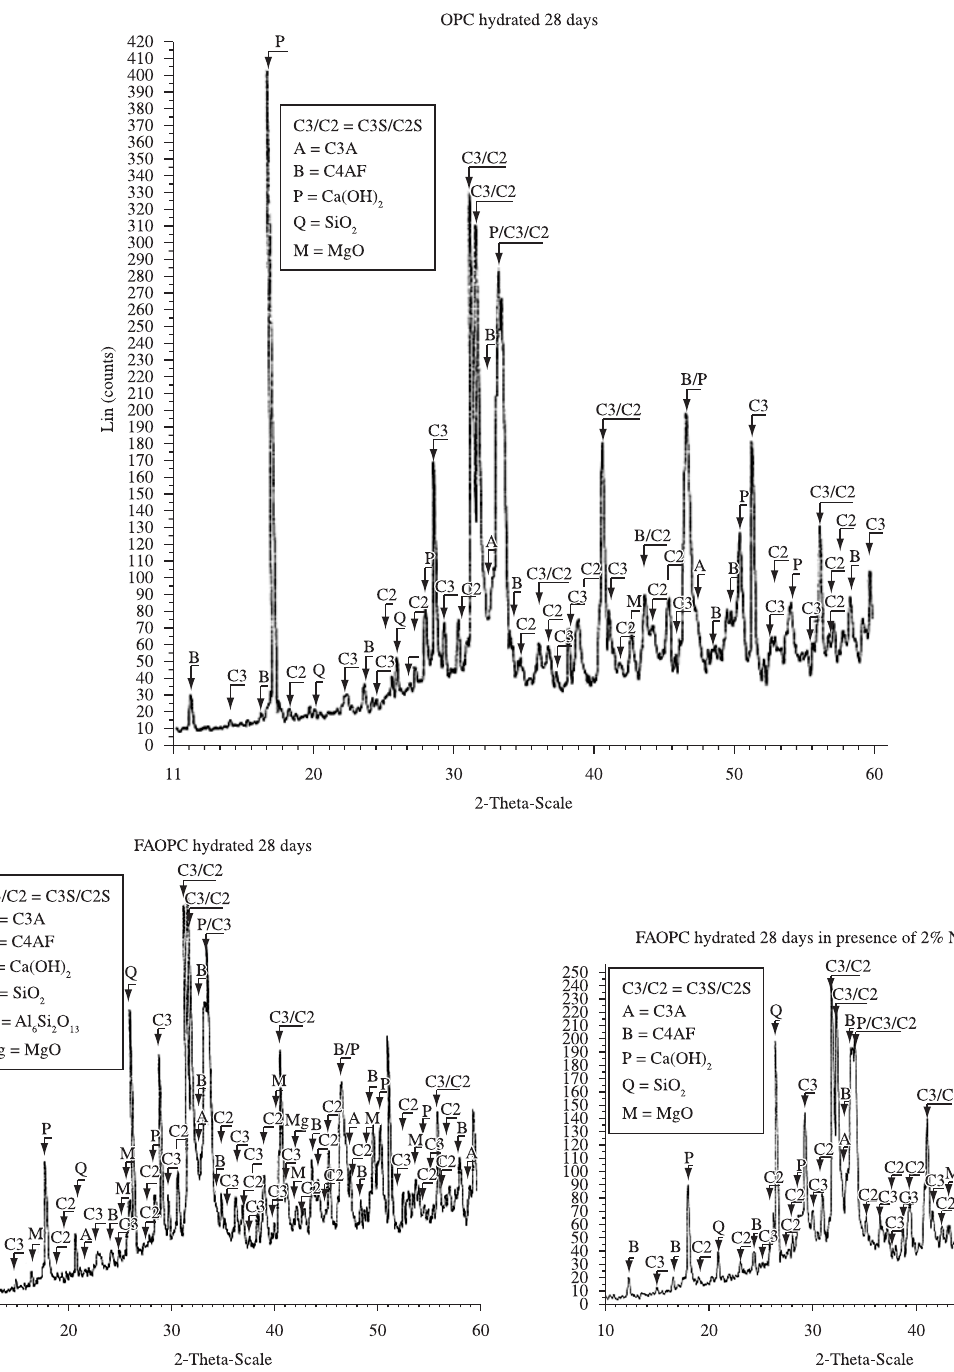
Figure 10. XRD patterns of 28 days hydrated sample.